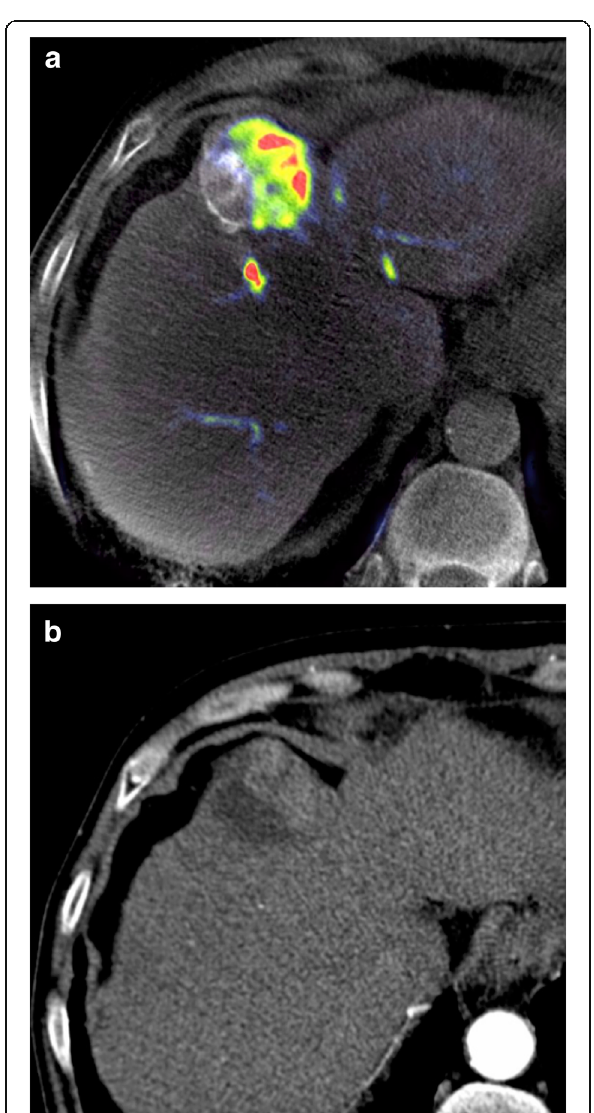
Fig. 2 a C-arm CBCT PBVI performed immediately after TACE via the artery to segment VIII showing high density contrast in the treated portion of the lesion. There is persistent viable tumor supplied via segment IVa. b Follow-up arterial phase MDCT confirming persistent viable tumor supplied via segment